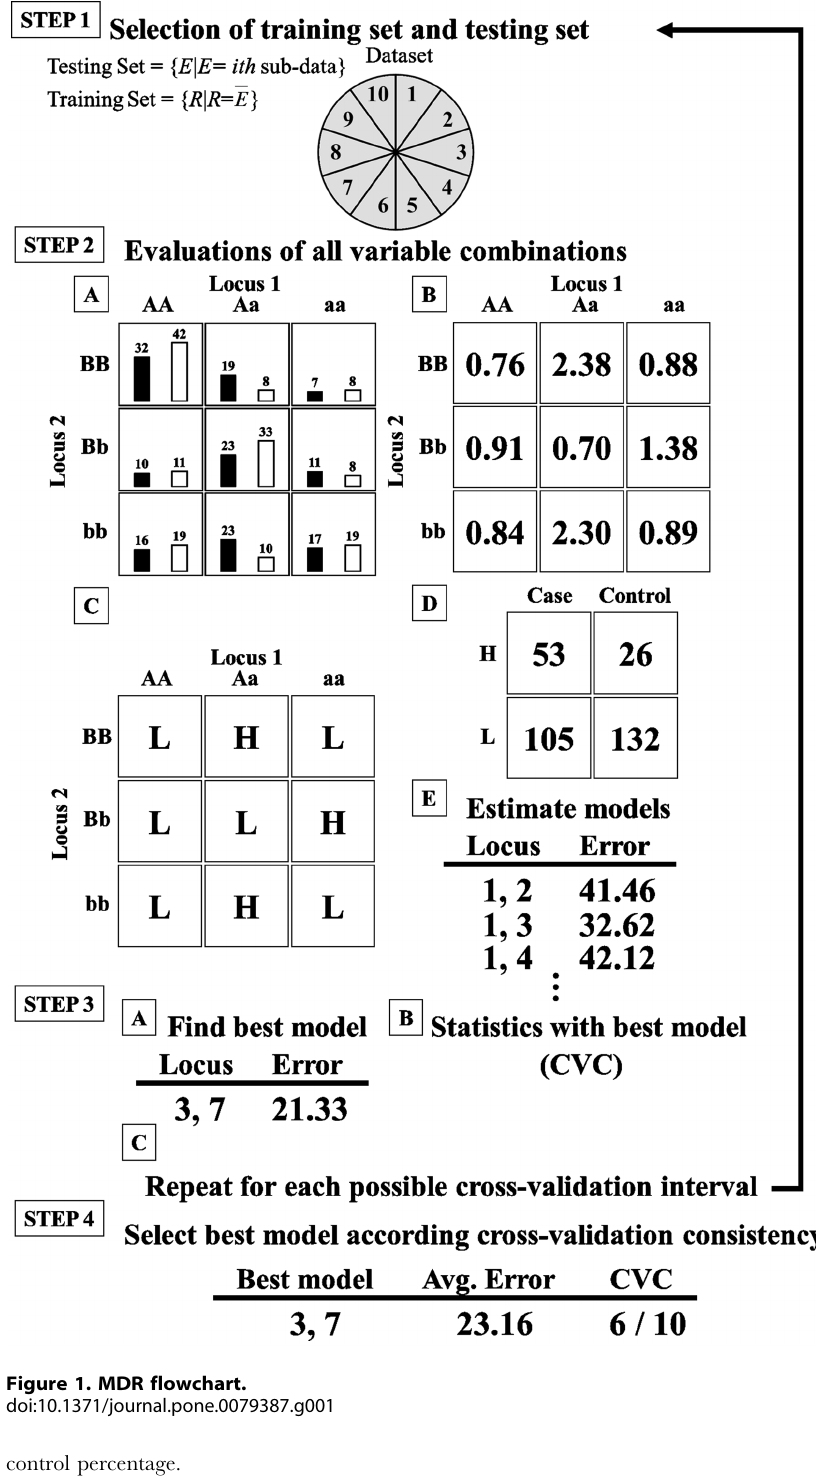
Figure 1. MDR flowchart.